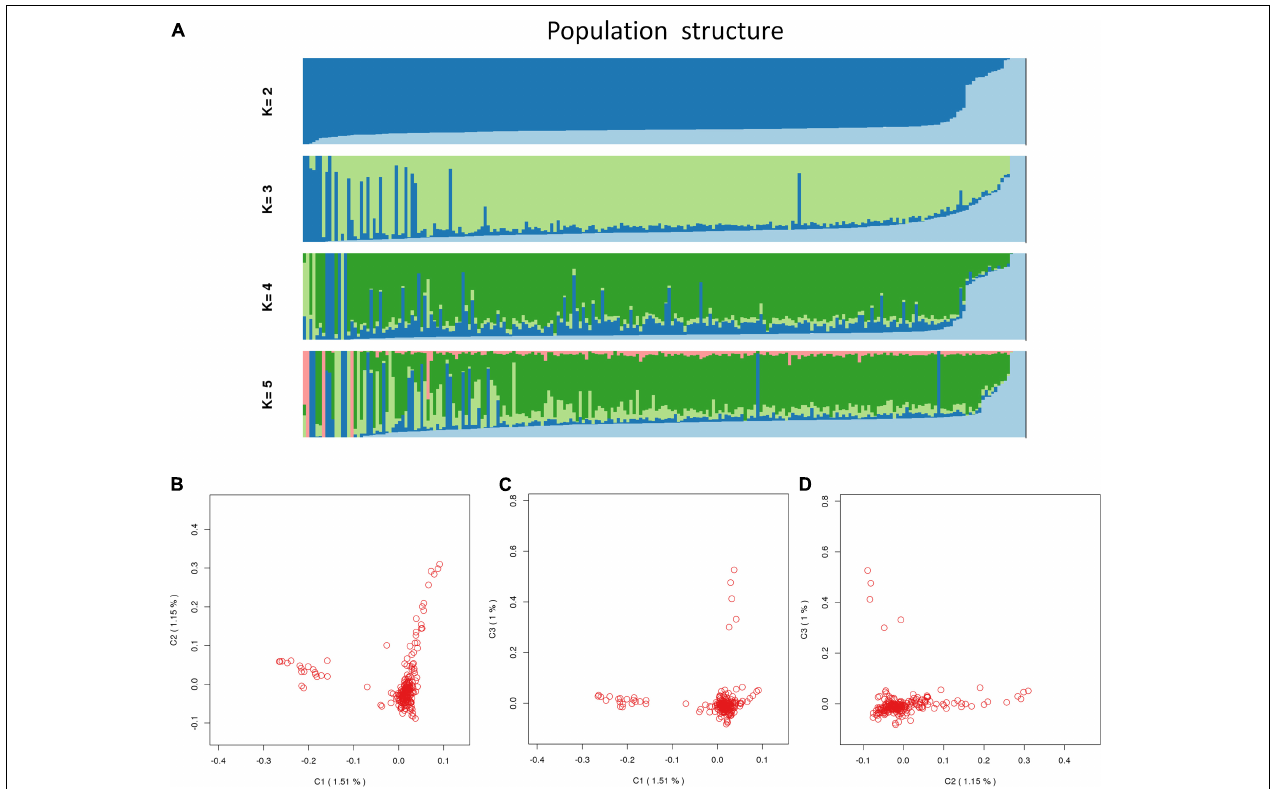
FIGURE 2 | Population_structure_by_Admixture. (A) Population structure with K from 2 to 5; (B) principal components (PC) plot drawn from the second principal component (C2) against the first principal component (C1); (C) principal components (PC) plot drawn from the second principal component (C3) against the first principal component (C1); (D) principal components (PC) plot drawn from the second principal component (C3) against the first principal component